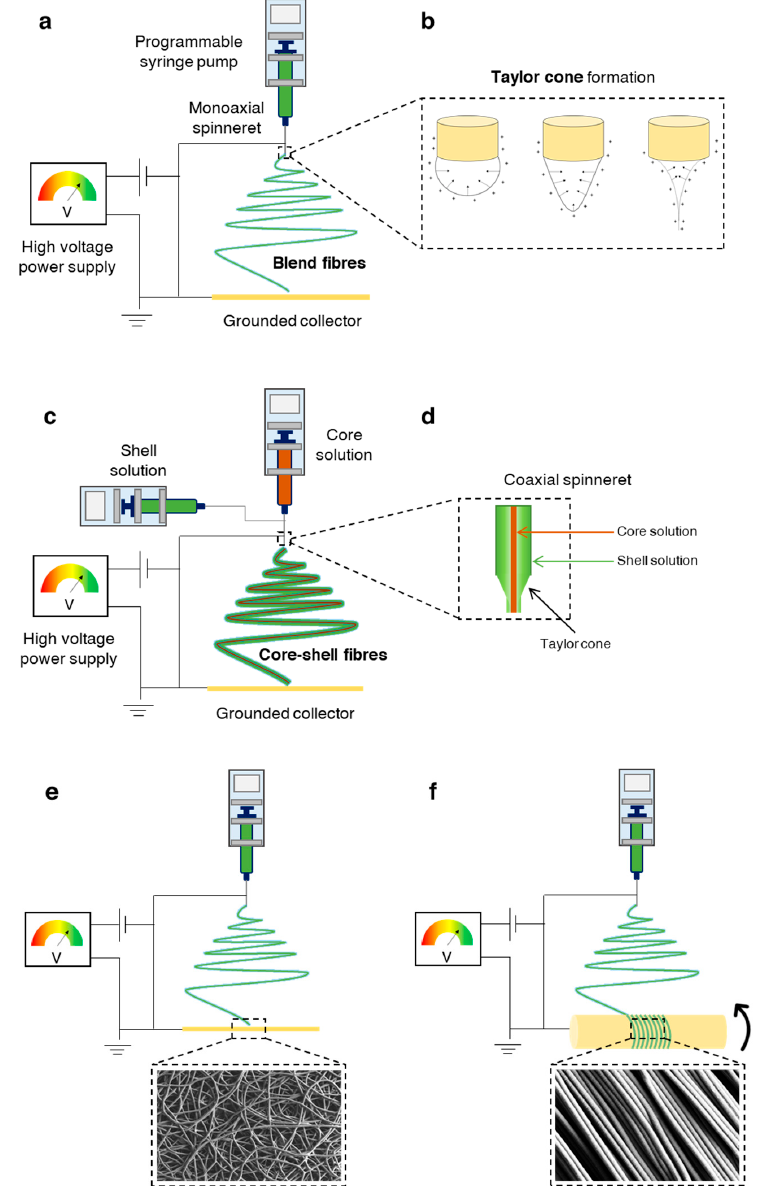
Figure 7. ( a ) Basic electrospinning setup. A programmable syringe pump is used to infuse a polymer solution, emulsion, or melt through an electrically conductive spinneret (e.g., a metallic needle), to which a high voltage (usually 5–20 kV) is applied. The accumulation of electrical charges in the polymer droplets at the tip of the spinneret leads to repulsive forces that eventually result in the formation of a cone shape, the Taylor cone ( b ), which is followed by the ejection of the liquid. While the majority of electrospinning studies report the use of a positive voltage at the nozzle, negative voltages can be applied instead (see ref. [284]). The jet is then accelerated towards a grounded or oppositely charged collector, the solvent is evaporated, and dry fibres are deposited. When a monoaxial (single-channel) spinneret is used, blend fibres are formed. Core-shell fibres can be produced using coaxial electrospinning ( c ), with the help of a coaxial spinneret ( d ) in which an inner solution (core), usually containing an active pharmaceutical ingredient, is enveloped by an outer solution (shell). The organisation of the deposited fibres can be controlled using different collector architectures: a flat collector ( e ) will generate randomly deposited fibres, while a cylindrical mandrel ( f ) rotating at high speeds will result in highly aligned fibres. The Taylor cone schematic representation in ( b ) was adapted from [285] with permission from Elsevier. Copyright © 2020, Elsevier B.V. The scanning electron microscopy (SEM) images in ( e , f ) were adapted from [275] with permission from Elsevier. Copyright © 2015, Elsevier